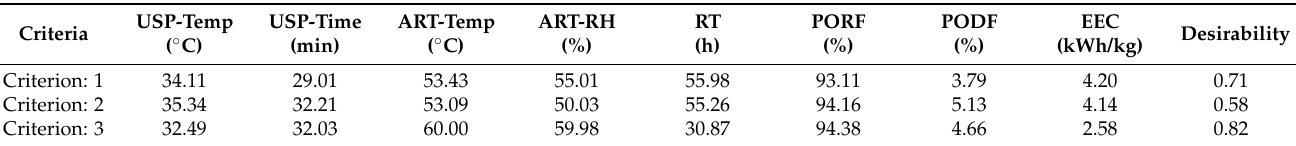
Table 5. The best solutions for satisfying the optimization criteria for USP-Temp, USP-Time, ART- Temp, ART-RH, RT, PORF, PODF, and